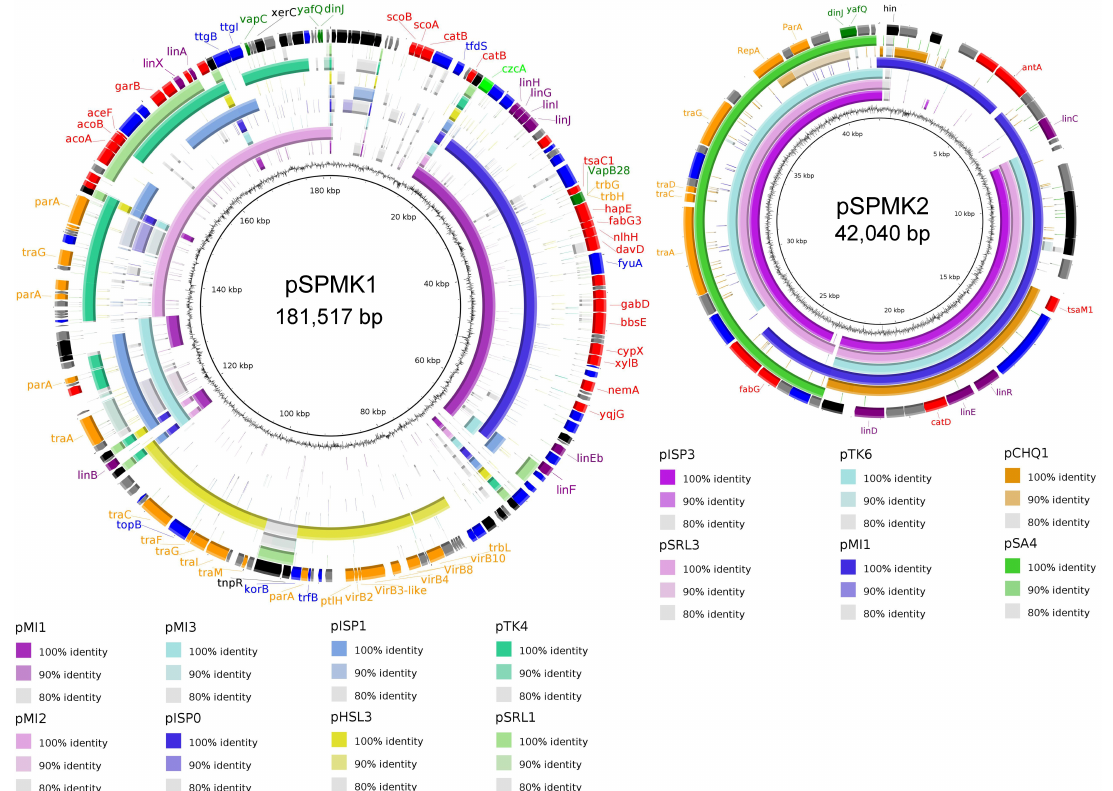
Figure 3. Comparative map of plasmid pSPMK1 and plasmid pSPMK2. Sequence similarity between pSPMK1 and pSPMK2 compared to selected plasmids derived from representative Sphingomonadaceace .